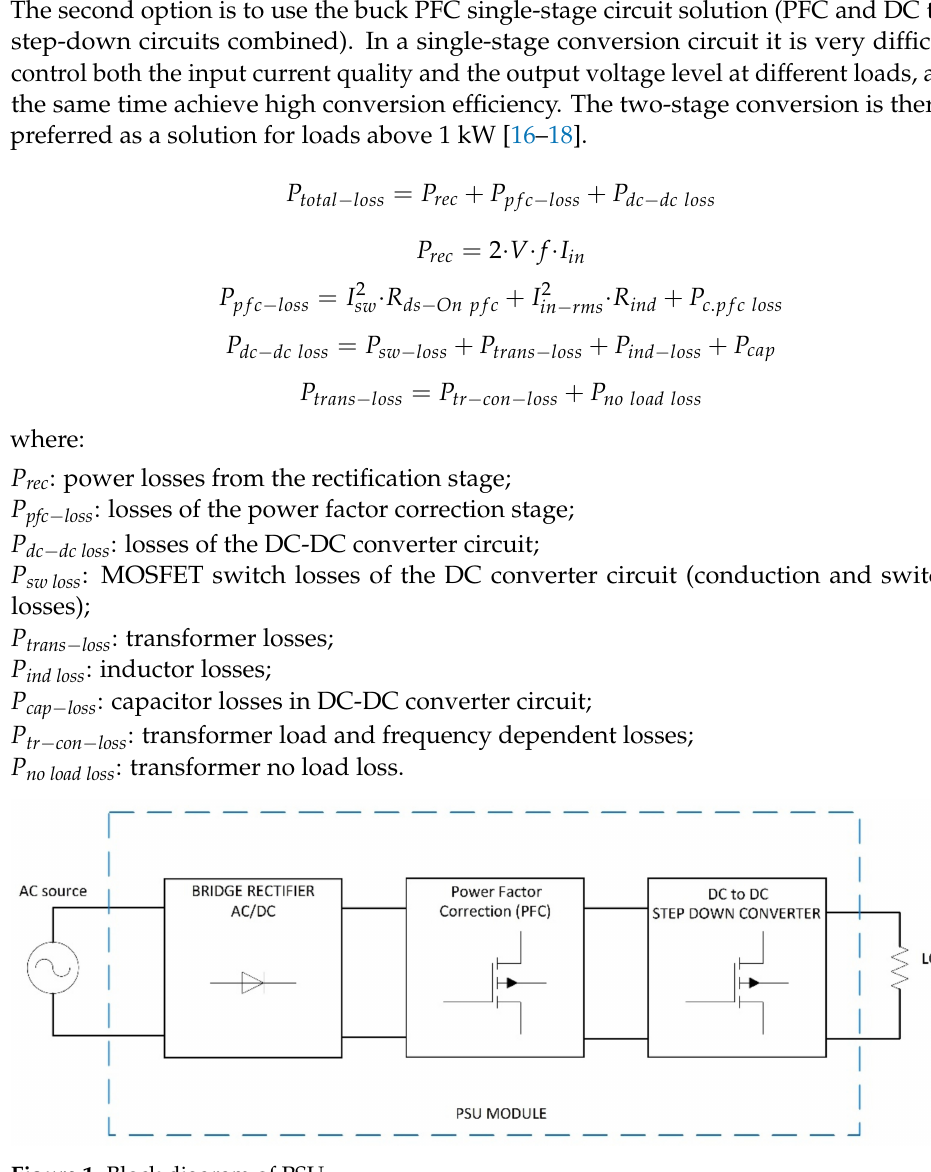
Figure 1. Block diagram of